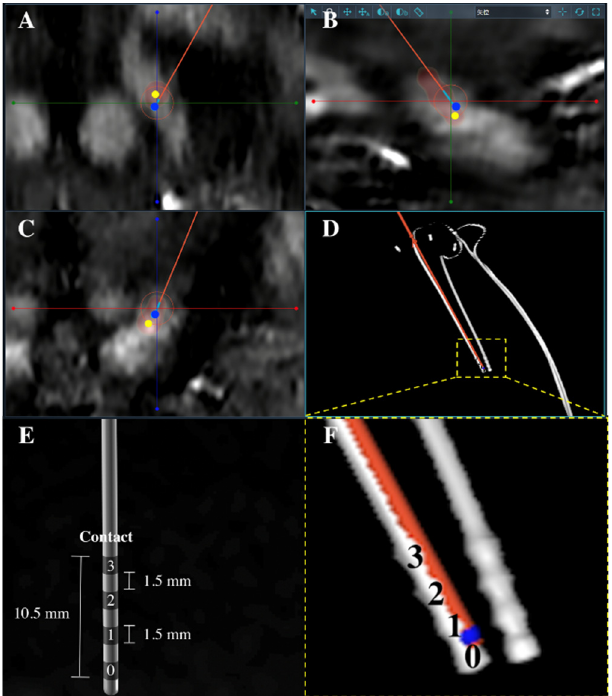
Figure 3. ( A – D ) The fusion image of postoperative CT scan with preoperative quantitative susceptibility mapping to display final electrodes positions. Red artifacts (high-density contacts on CT scans were manually set to red) were final positions of contacts of leads. The center of the distal contact (yellow dot) was recorded as x a , y a , and z a to represent the actual position of leads. The tip of the planned trajectory (blue dot) was recorded as x i , y i , and z i to represent the intended position of leads. The vector error was calculated by the formula of √ (x i − x a ) 2 + (y i − y a ) 2 + (z i − z a ) 2 . ( E ) The model of a Medtronic 3387 quadripolar lead has four contacts (the distal contact: contact 0) ( F ) The enlarged view of the planned trajectory (red) and the actual lead implantation (white). The actual distal contact is contact 0.